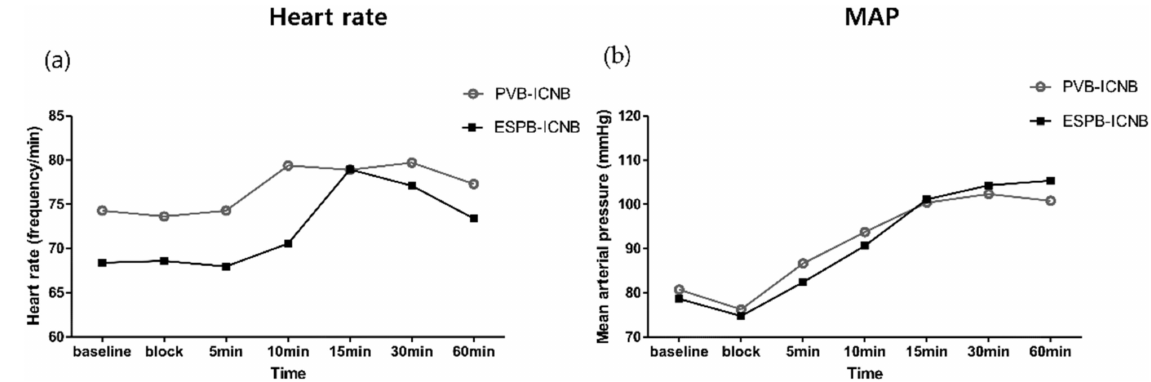
Figure 2. Hemodynamic data: ( a ) Heart rate; ( b ) Mean arterial